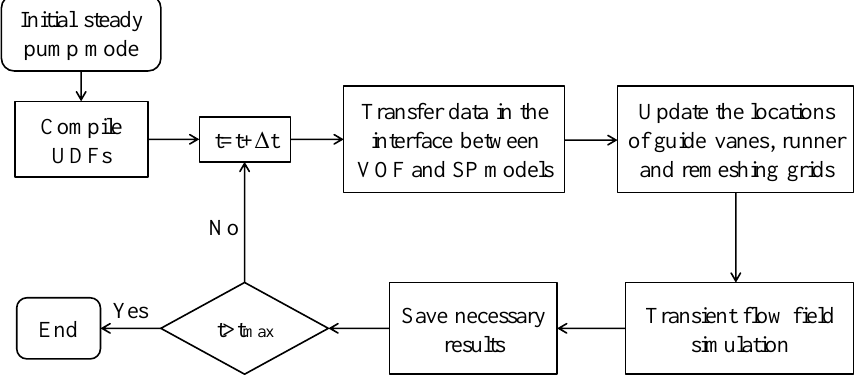
Figure 2. Algorithm routines of pumped storage hydropower (PSH) power-off transient simulation.